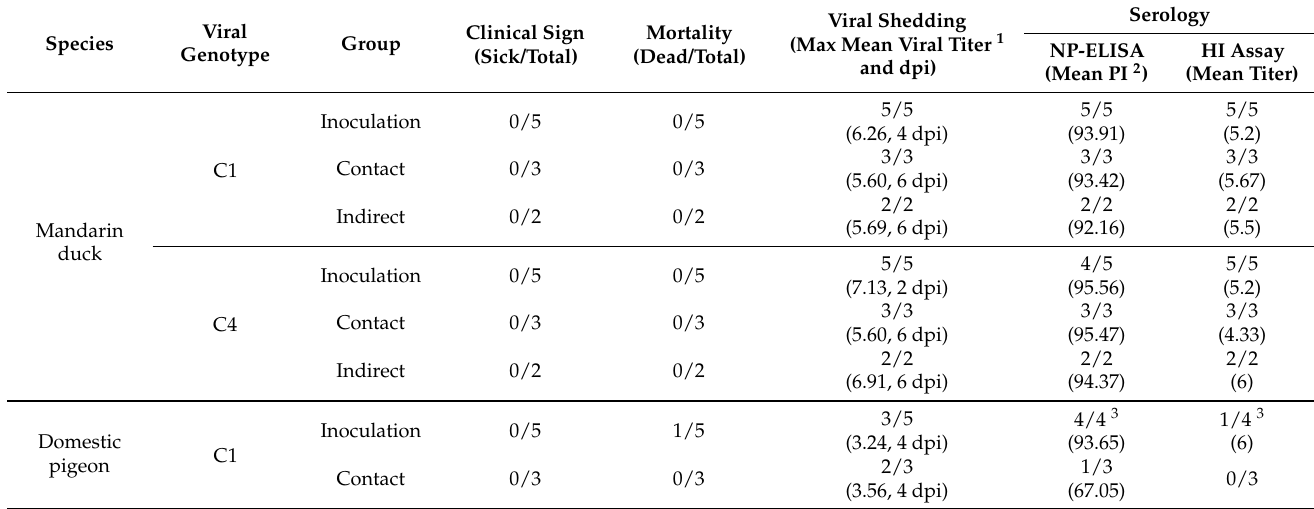
Table 1. Summary of clinical signs, viral shedding, and serology in mandarin ducks and domestic pigeons infected with clade 2.3.4.4 H5N6